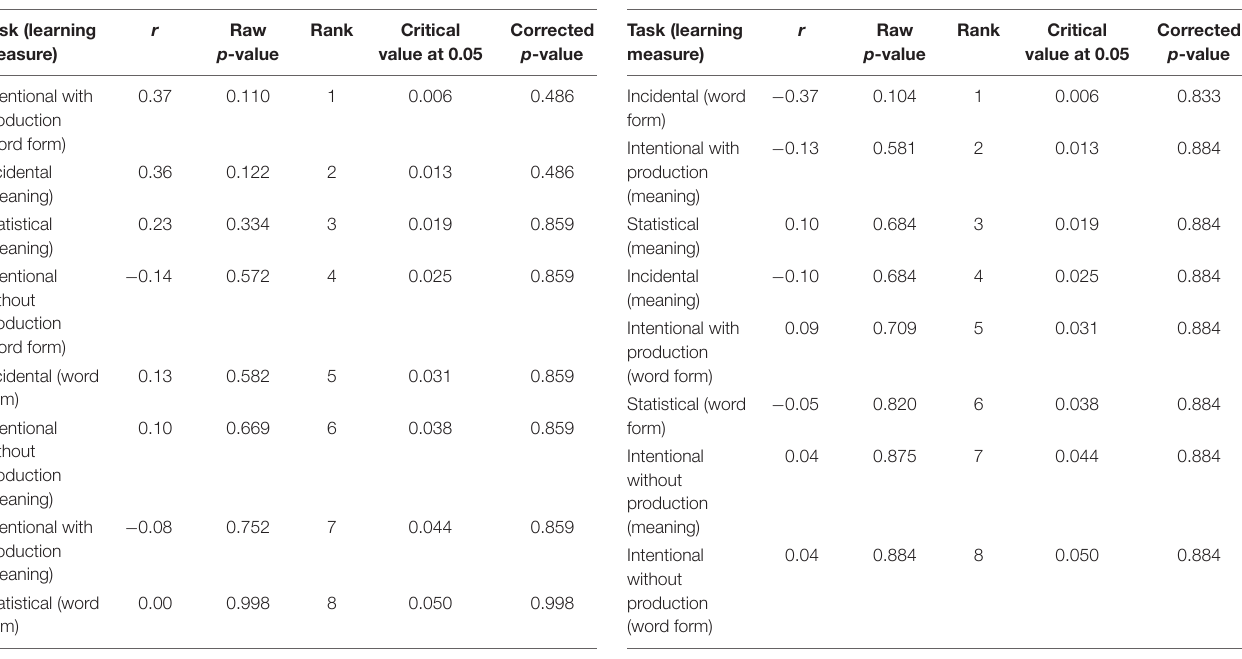
TABLE 6 | Correlations between Block Design and learning performance with critical values of the Benjamini–Hochberg correction at an FDR of 0.05 and corrected p -values.